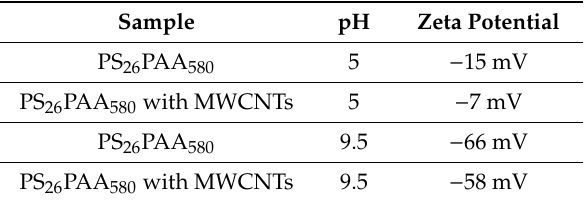
Table 2. Zeta potential of polymer samples in water (6 mg/mL). MWCNTs were added for some samples with a feed of 0.22 mg/mL. Ten cycles were performed.